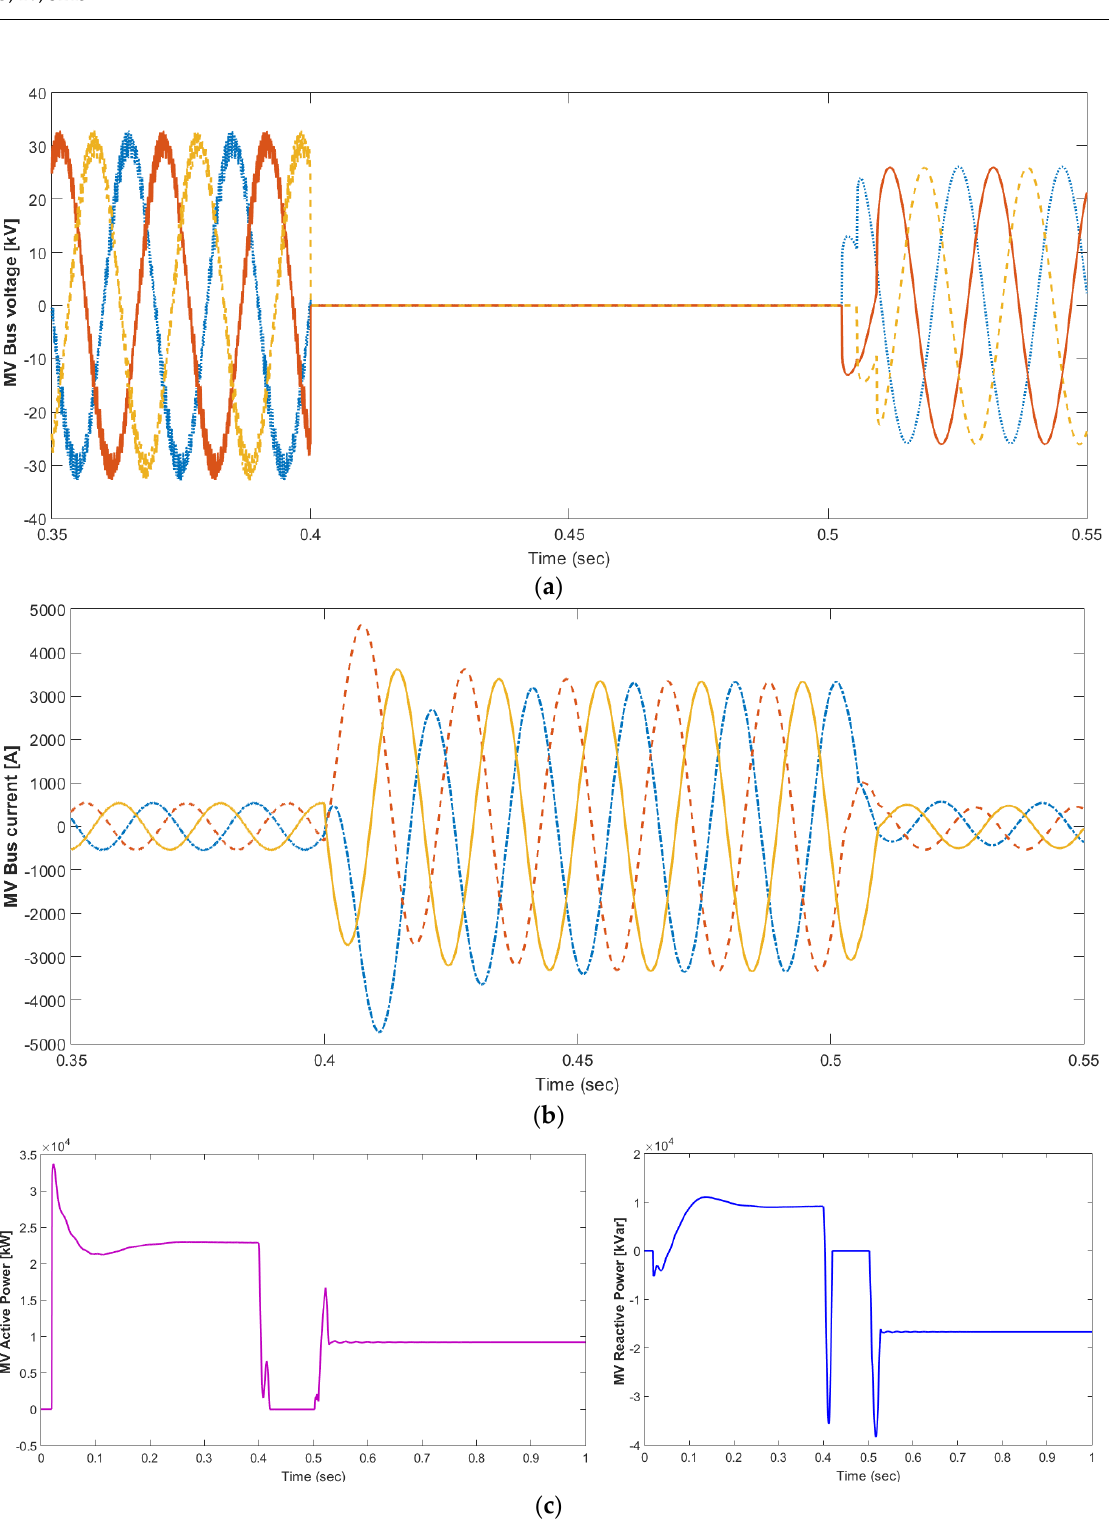
Figure 7. ( a ) Voltage at the MV bus in the case of a three-phase-to-ground fault. ( b ) Currents at the MV bus during a three-phase-to-ground fault. ( c ) Supplied active and reactive powers by each PV generator to the MV bus.